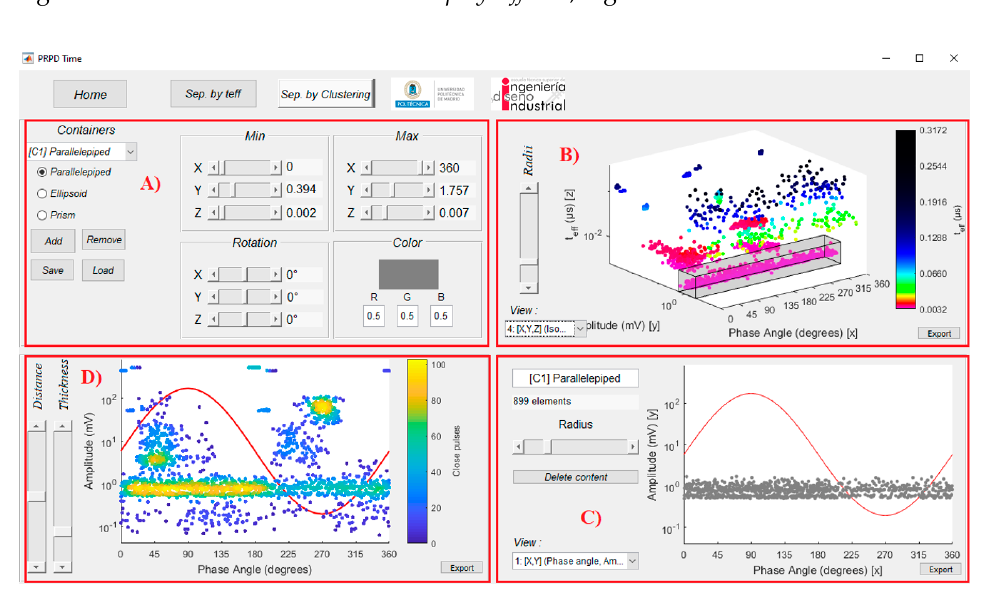
Figure 6. Graphical interface for pulses separation using the PRPD- t eff patterns. ( A ), Container definition: geometry, origin location and size; ( B ) container geometry plotted in the PRPD- t eff pattern;